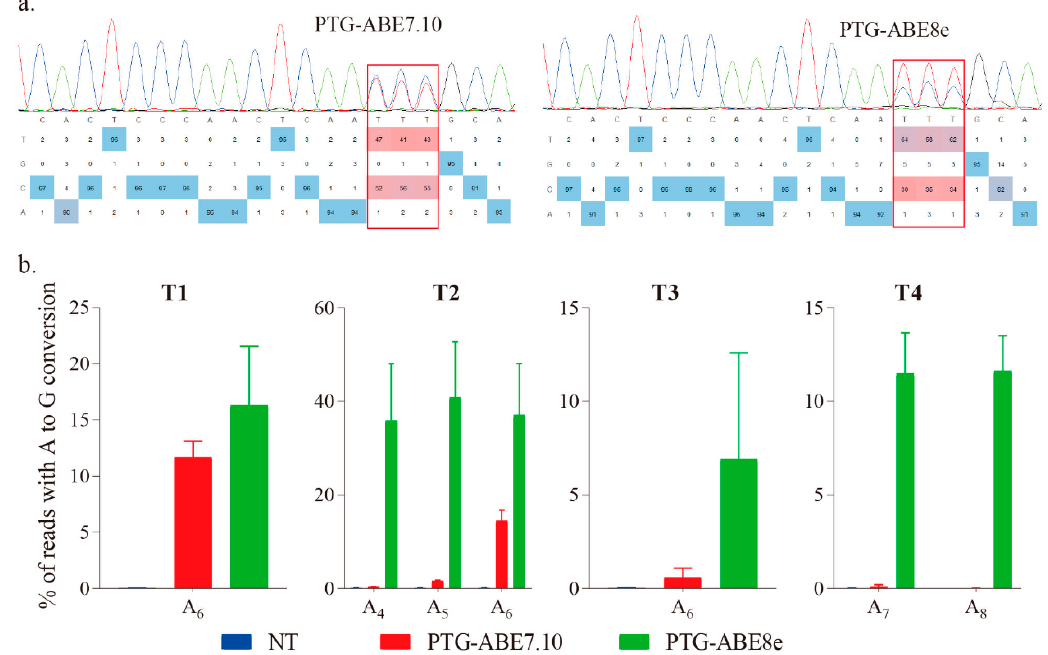
Figure 2. Estimation of A-to-G base editing induced by PTG-ABE7.10 and PTG-ABE8e in N. benthamiana . ( a ) Sanger sequencing chromatograms of the T2 target for PTG-ABE7.10 and PTG-ABE8e. The sequencing chromatograms show the results sequenced from the reverse direction. Red squares indicate the edited bases induced by ABEs. ( b ) Frequencies of A-to-G conversions induced by PTG-ABE7.10 and PTG-ABE8e at four target sites based on amplicon deep sequencing results. Frequencies (mean ± SEM) were calculated from three independent experiments ( n = 3). NT, no-treatment.